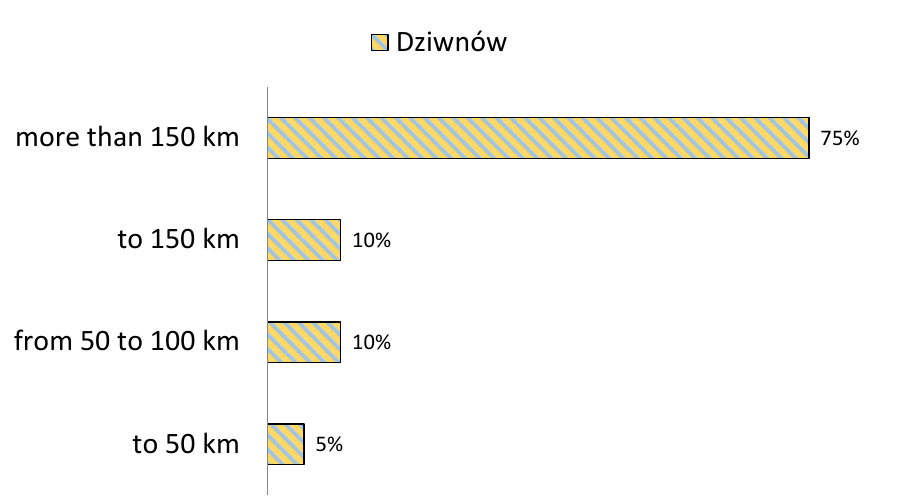
Figure 9. Distance distribution for missions that started from EPOK and EPDA bases in 1995–2001; W3-RM and Mi-13PS helicopters were used.